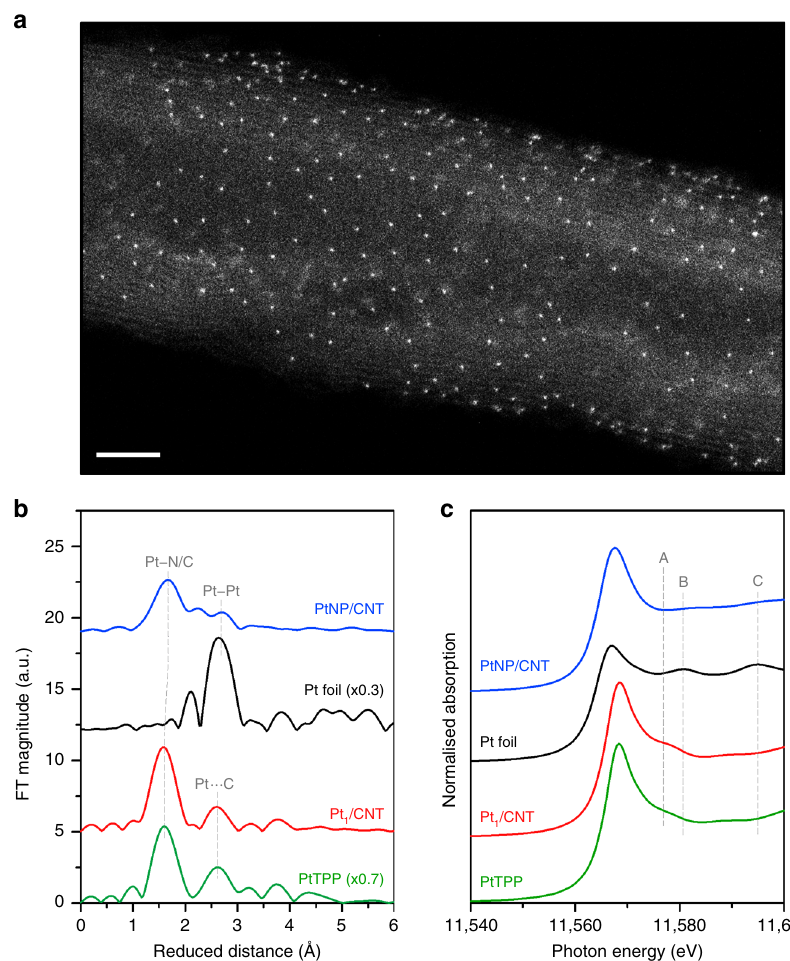
Fig. 1 Characterisation of Pt 1 /CNT catalyst comprising atomically dispersed Pt − N 4 sites on the surface of CNT. a HAADF-STEM image of Pt 1 /CNT catalyst. Scale bar: 3 nm. b k 3 -weighted Pt L 3 -edge EXAFS spectra and c XANES spectra of Pt 1 /CNT and PtNP/CNT catalysts, along with PtTPP precursor and Pt foil